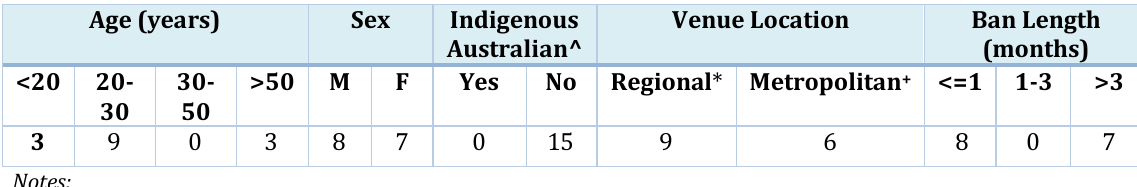
Table 1: Interview Participant